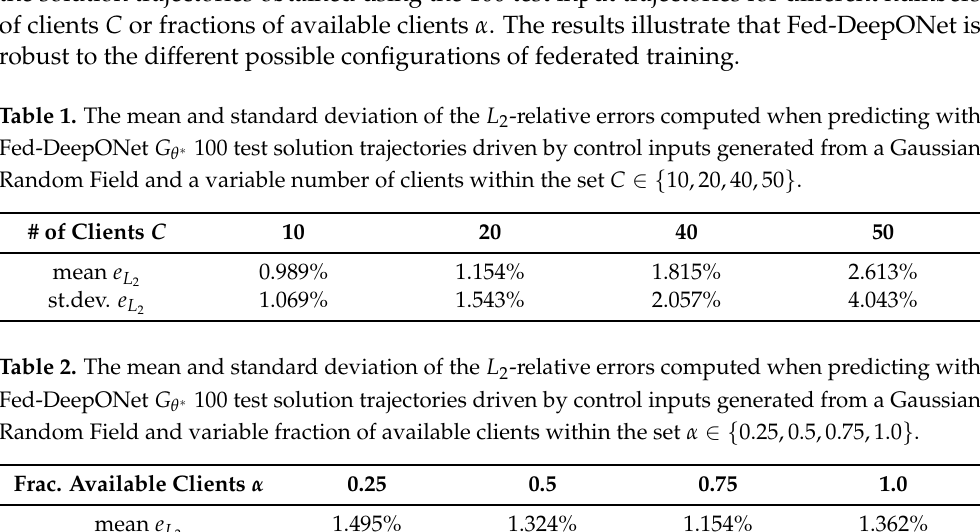
= 1.813%, ( middle ) e = 0.748%, and ( right ) e = 2.296%. L 2 L 2 2 for 2